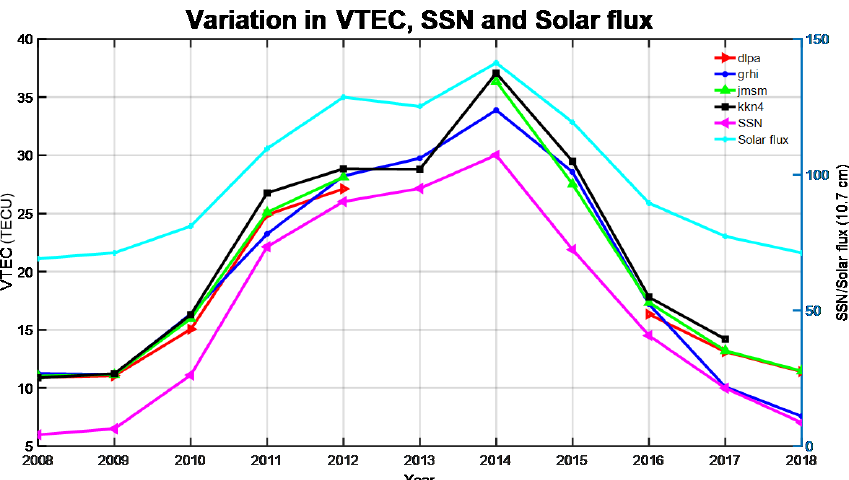
VTEC is maximum. As the solar flux decreases from 2008 to 2009, the daily maximum VTEC values show a decreasing